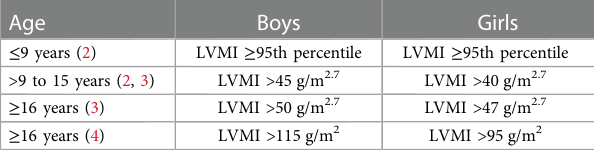
TABLE 4 De fi nitions of left ventricular hypertrophy (LVH) by age and sex.